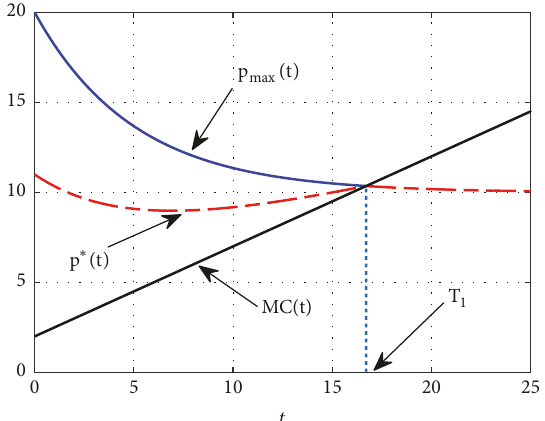
Figure 6: Comparison of dynamic pricing strategy and fixed price